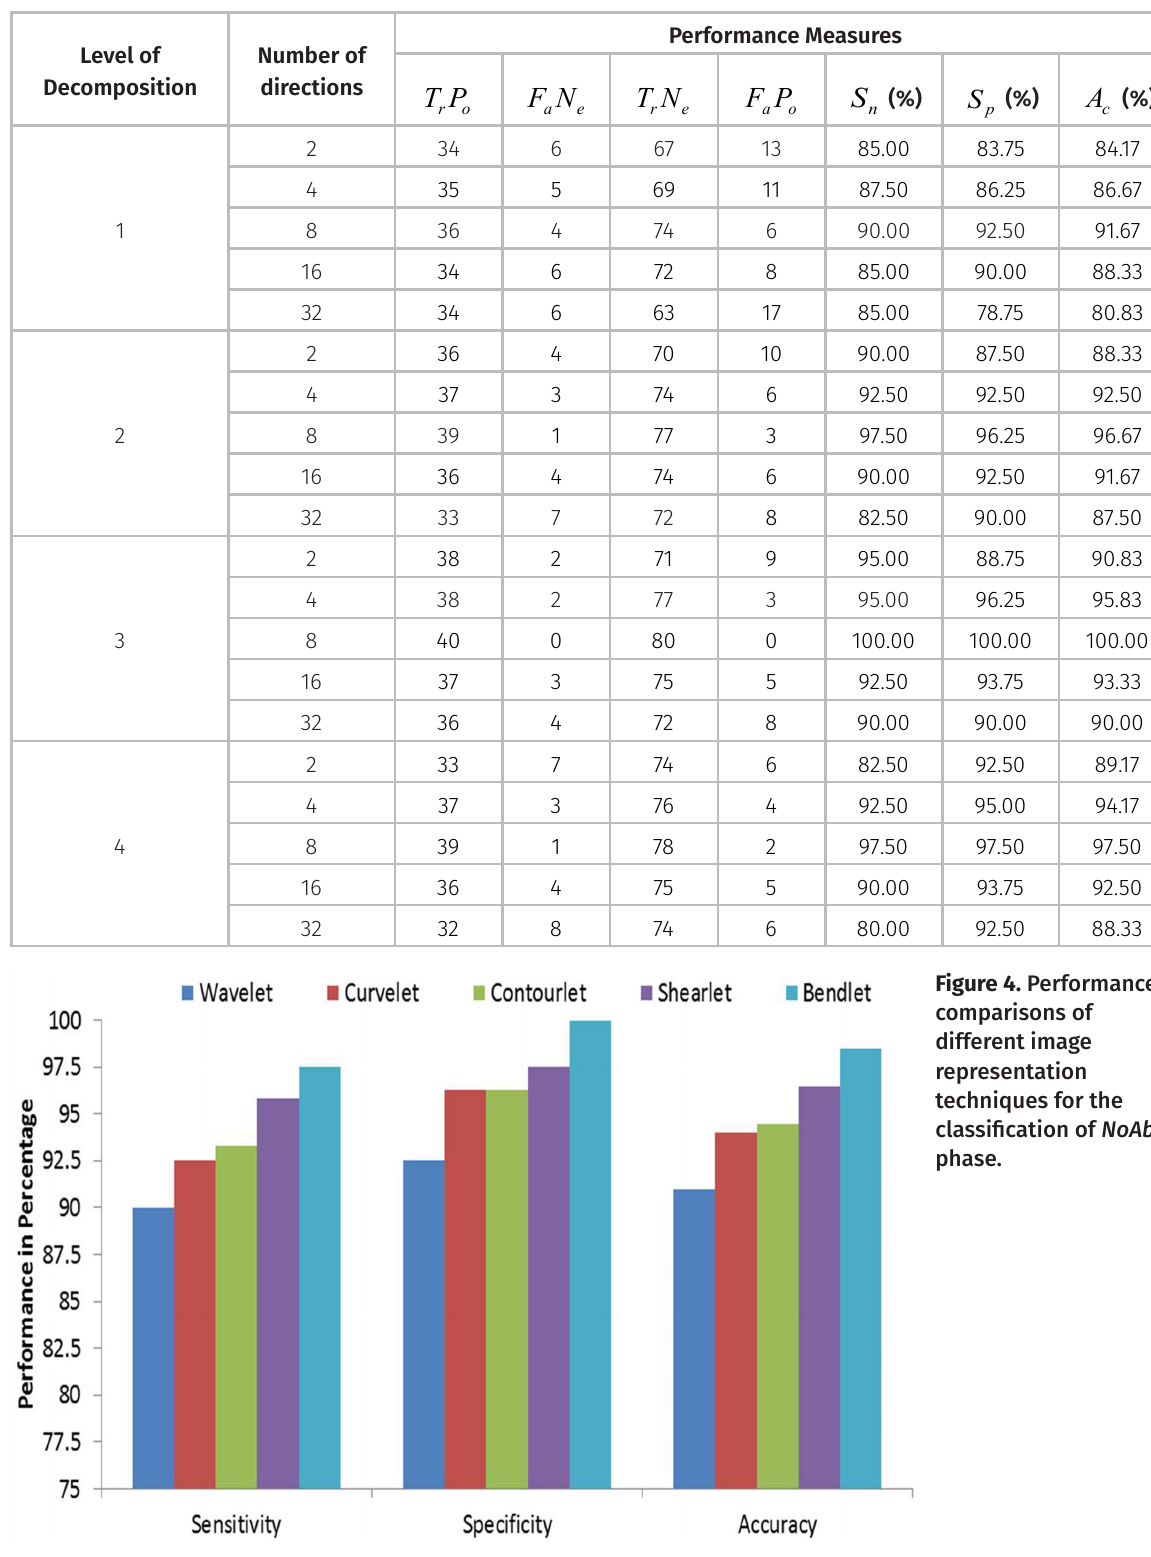
Performance Measures